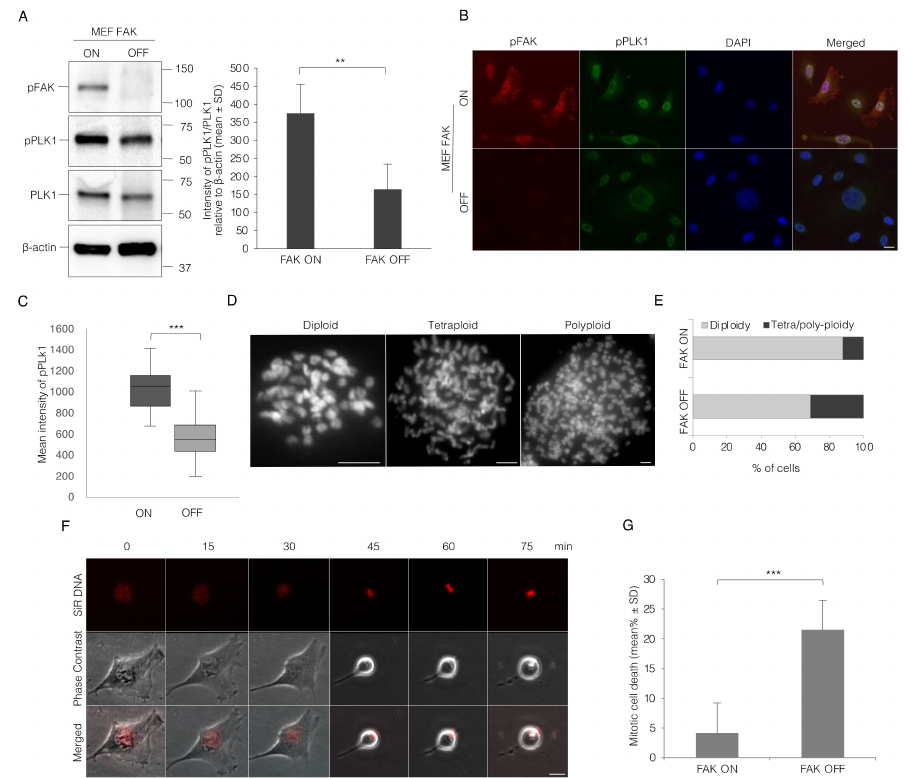
Figure 6. Inhibition of FAK expression reduces the activity of PLK1 and causes frequent mitotic cell death and tetraploidy. ( A ) Representative Western blot pictures and quantification of the bands showing the difference in the level of pPLK1 relative to the total level of PLK1 and β -actin, and pFAK in the mitotic Tet-FAK-ON and -OFF MEF cells re-plated on fibronectin for 60 min. ( B ). Decrease of pPLK1 in the cells lacking FAK expression after 72 h treatment with doxycycline and 5 h after release from the double thymidine block. Representative micrographs illustrating the pPLK1 (green) signals in Tet-FAK ON and OFF cells. Scale bar, 20 µ m. ( C ) Box plots showing the average intensity of pPLK1 in 100 cell nuclei. ( D ) Representative pictures of Tet-FAK OFF cells with different ploidy. The chromosomes were stained by DAPI. Scale bar, 5 µ m. ( E ) The % of mitotic cells having diploid or tetra/polyploid chromosome sets. A total of 500 chromosome plates were analyzed for each condition of FAK ON and OFF. ( F ) Snapshot images from a time-lapse movie displaying the mitotic progression of a single FAK OFF cell from the beginning of mitosis (0 min time point) to cell death at the later time point. The nucleus was labeled with SiR-DNA (red). Scale bar, 50 µ m. ( G ) Mean (%) ± SD of the number of mitotic cells that die during the early mitotic progression after rounding up. p -values less than 0.01, and 0.001 were shown by two and three stars,